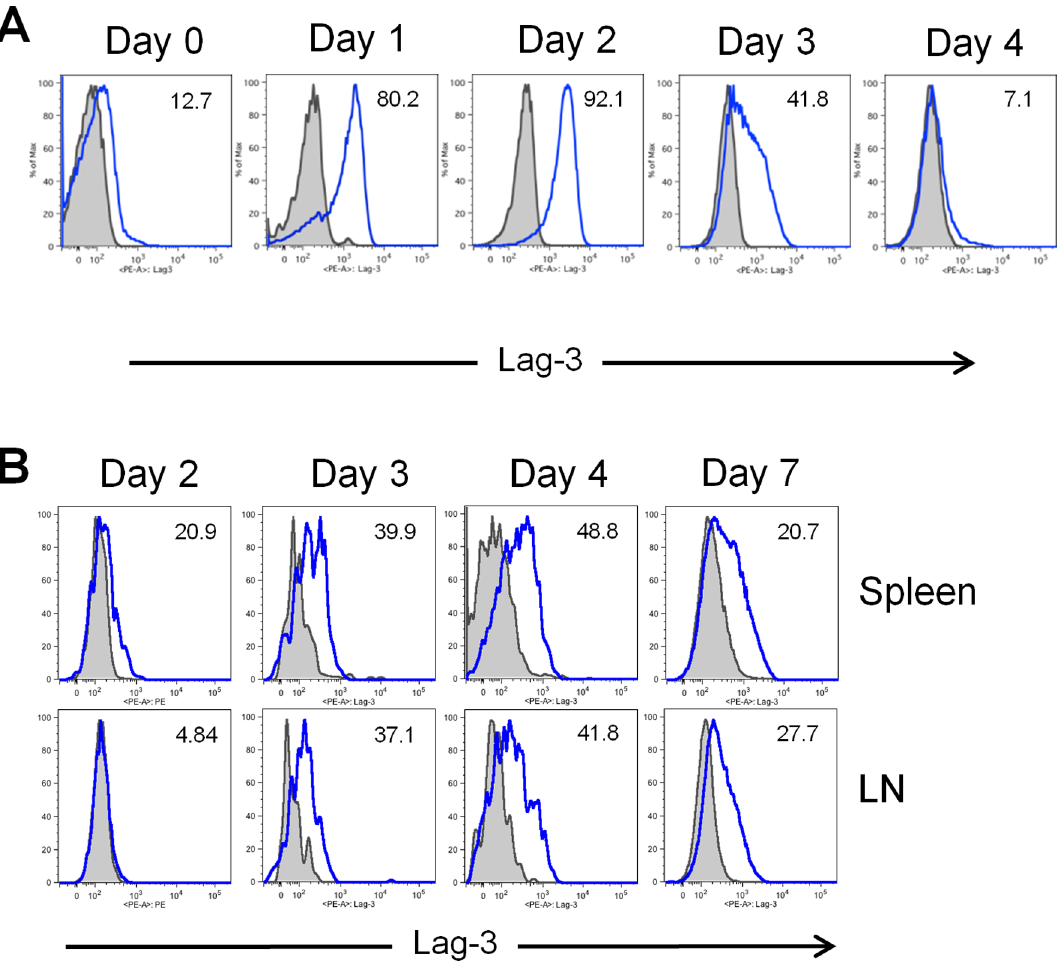
Figure 1. Surface expression of Lag-3 increases upon T cell activation invitro and invivo . (A) T cells were incubated with anti-CD3/anti- CD28 activation beads in the presence of 1000 U/mL hrIL-2. Lag-3 expression was assessed over a period of 7 days. The grey solid histograms represent cells stained with isotype control Ab. Cells were gated on CD4 + and the numbers in the right side corner represent the percentage of Lag-3 positive cells. Data is representative of 3 independent experiments. (B) Balb/c (H-2K d ) recipients were co-transplanted with 5 6 10 6 TCD-BM and 1 6 10 6 Tcon from C57Bl/6 (H-2K b ) mice. At indicated time points after transplantation, donor T cells were re-isolated from spleen and LN and analyzed for Lag-3 expression. Grey histograms represent cells stained with isotype controls. Cells were gated on donor CD4 + cells and the numbers in the right side corner represent the percentage of Lag-3 positive cells. Data is representative of two independent experiments. (Fig. 2C). GVHD scores for Lag-3 2 / 2 Tcon recipients were significantly higher than for those receiving WT Tcon at early and late time points (Day 5, Fig. 2D; day 25, Fig. 2E). In addition to the clinical parameters that indicate higher GVHD scores for Lag- 3 2 / 2 Tcon recipients, histopathological analysis of large and small intestine at day 8 after transplant also reveal a more severe GVHD in the absence of Lag-3 on Tcon. As shown in Fig. 2F, the colon of Lag-3 2 / 2 Tcon recipients lost the normal microarchitecture of the large intestinal glands, the goblet cells that normally line the intestinal glands were replaced by poorly-differentiated epithelial cells with evidence of hyperplasia, there was a greater inflamma- tory cell infiltrate in both the lamina propria and the intestinal gland lumina, and a larger number of apoptotic bodies within the epithelial layer. There was a more severe loss of the crypt microarchitecture of the small intestine when mice were transplanted with Lag-3 2 / 2 Tcon. The Paneth cells lining the crypt were replaced with hyperplastic, poorly differentiated epithelial cells with marked basophilia and mitoses, and, similar